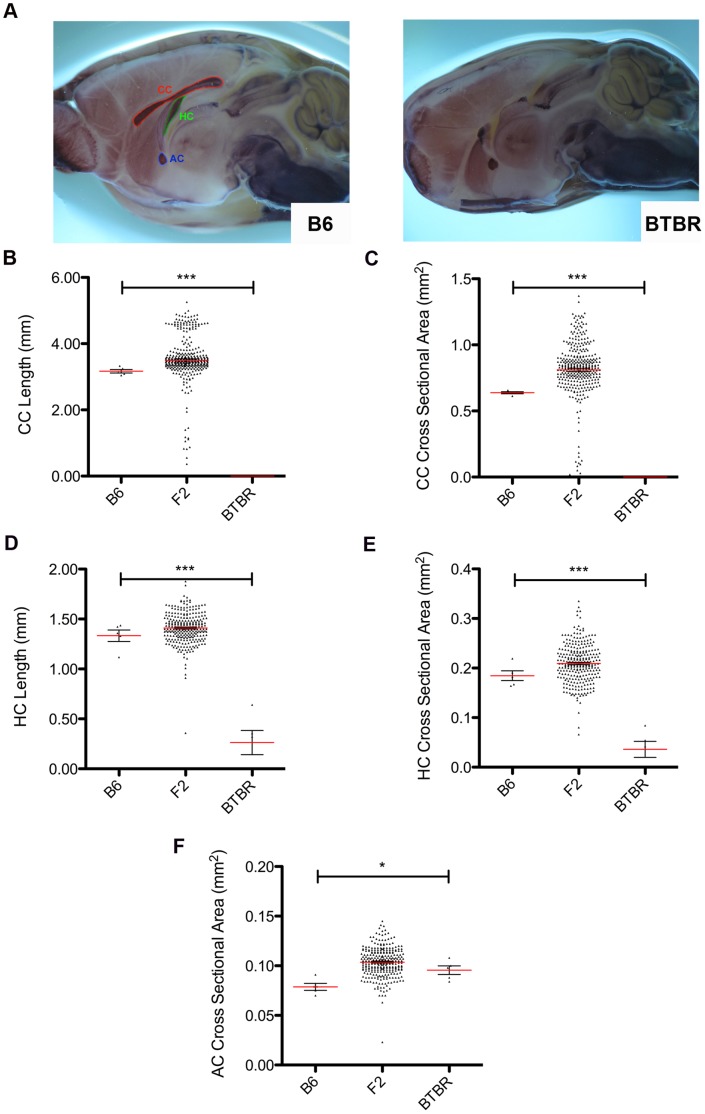
Callosal phenotype of the BTBR T+
tf/J mouse.(A) As compared to the C57BL6/J mouse strain, a midsaggital section of the BTBR T+
tf/J mouse brain displays deficits in the formation of commissural structures (CC – red, HC – green; AC – blue); (B, C) a complete loss of the corpus callosum (CC), a reduction in the (D) length and (E) area of the hippocampal commissure (HC), and (F) a slightly enlarged anterior commissure (AC). (B,–F) Graph of the distribution of (B) corpus callosum, and (D) hippocampal commissure lengths, and (F) anterior commissure areas of F2 intercrossed progeny, indicates a widespread distribution.